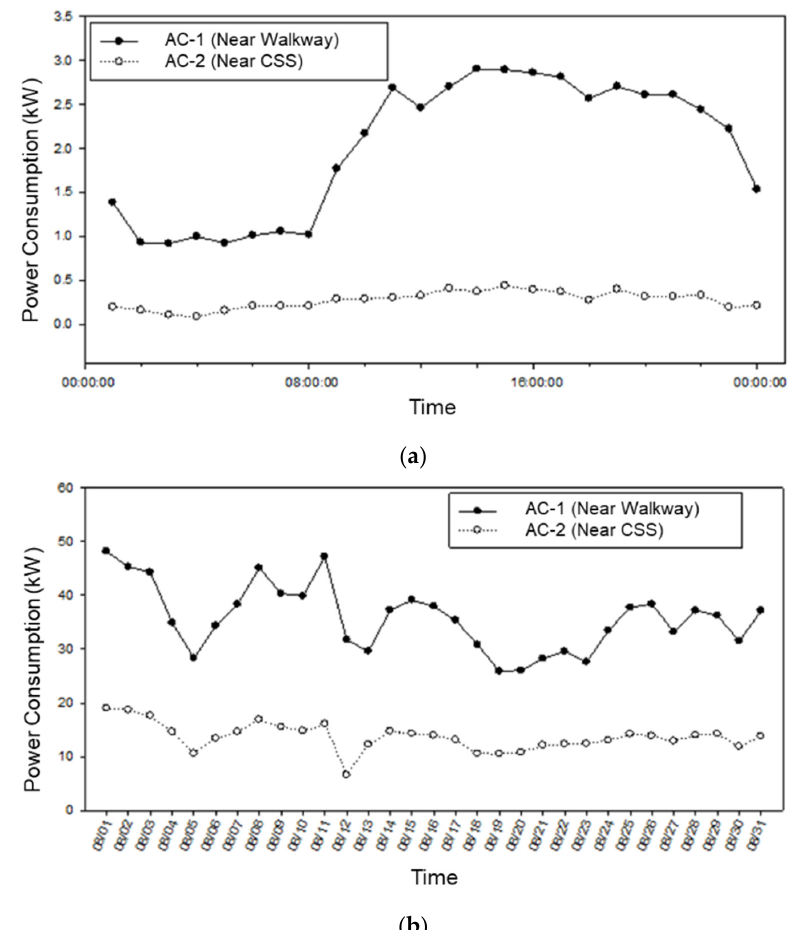
Figure 6. Power consumption of AC system; ( a ) 24-h; ( b ) monthly.